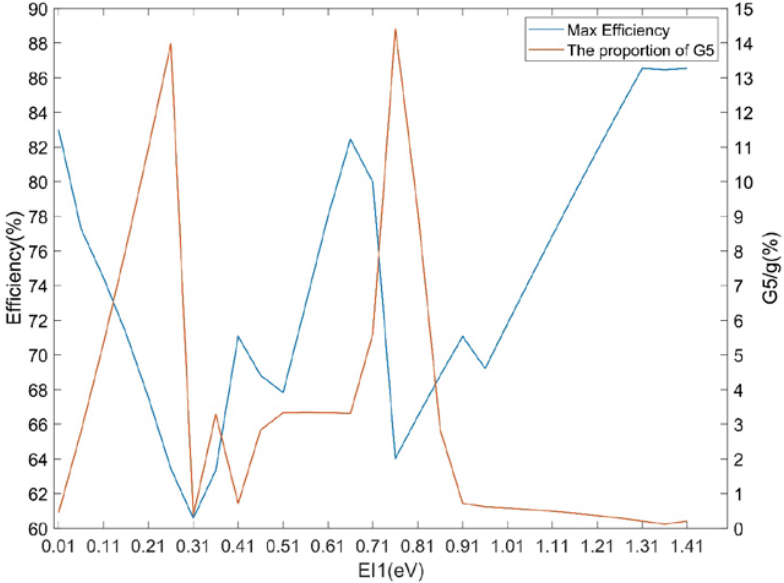
Figure 6. Maximum efficiency and the value of G 5 /g for a certain E I 1 when E I 2 changes from 0.01 eV to 1.41 eV. Only the point of maximum efficiency is shown.